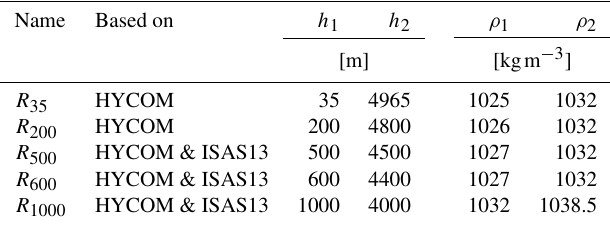
Table D1. Characteristics of the layers for the baroclinic cases of the Rossby wave